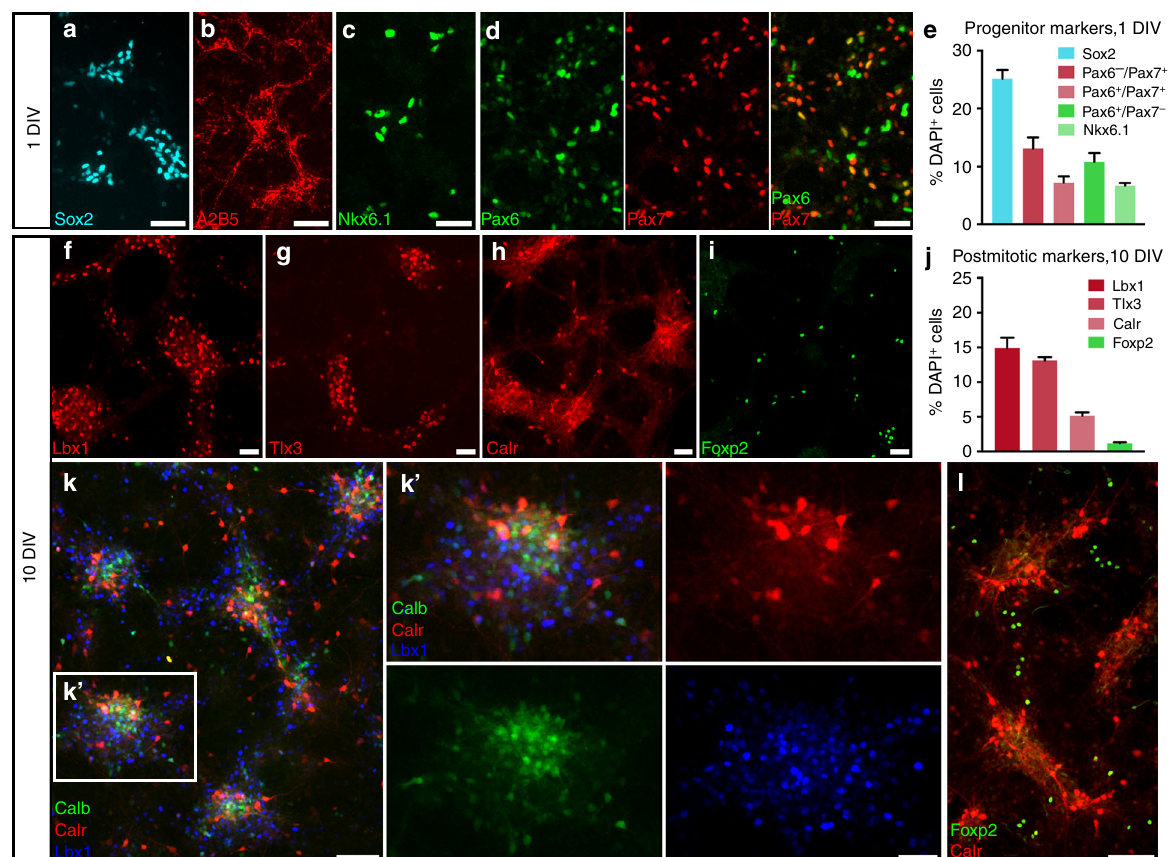
Fig. 1 Dissociated spinal cord NPCs differentiate into dorsal and ventral neuronal lineages in vitro. Spinal cords from E14 rat embryos were dissociated, and cells were cultured for either ( a – e ) 24 h or ( f – l ) 10 days. a Sox2 + neuronal progenitors and b A2B5 + glial progenitors are both present at 1 day in vitro (DIV). c Nkx6.1 + , d Pax6 + (green) and Pax7 + (red) progenitors are present at 1 DIV. Pax6 is expressed in both dorsal and ventral progenitors, but all Pax7 + cells are dorsally-fated. e Quanti fi cation of percent of total cells expressing NPC markers at 1 DIV; mean + SEM based on total cell counts for 3 independent biological replicates. f Lbx1 + , g Tlx3 + , h calretinin + (Calr), and i Foxp2 + cells are present at 10 DIV. j Quanti fi cation of percent of total cells expressing markers of dorsal (Lbx1, Tlx3, calretinin) and ventral (Foxp2) post-mitotic neurons at 10 DIV; mean + SEM based on total cell counts for 4 different biological replicates. k Neurons expressing dorsal horn markers calretinin (red), calbindin (green), and Lbx1 (blue) are located within the same cell clusters after 10 days in culture. k ’ High-magni fi cation view of boxed area in ( k ) demonstrates clustering of multiple dorsal interneuron subtypes. l In contrast, Foxp2 + (green) ventral interneurons are not located within dorsal interneuron clusters. Scale bars = 100 μ m ( k , l ), 50 μ m ( a – d , f – i , k ’